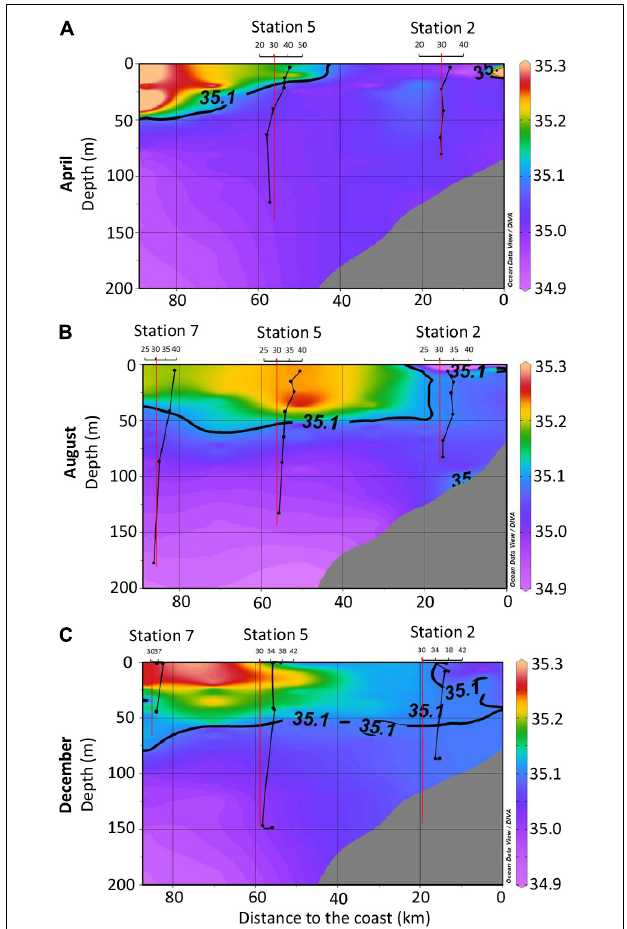
FIGURE 4 | Solid-phase extractable dissolved organic carbon (SPE-DOC) concentrations for April (A) , August (B) , and December (C) 2015. The color indicates the salinity distribution (compare to Figure 2B ). Black vertical lines represent the SPE-DOC concentration at the investigated stations (axis legend on top). The red vertical lines mark the limit of 30 µ mol L − 1 ; this was done only for visualization reasons. In order to achieve a better resolution of the plots, further data for deeper water depths at station 7 for August and December were omitted in the plots: August station 7 at 500 m: 27 µ mol L − 1 ;